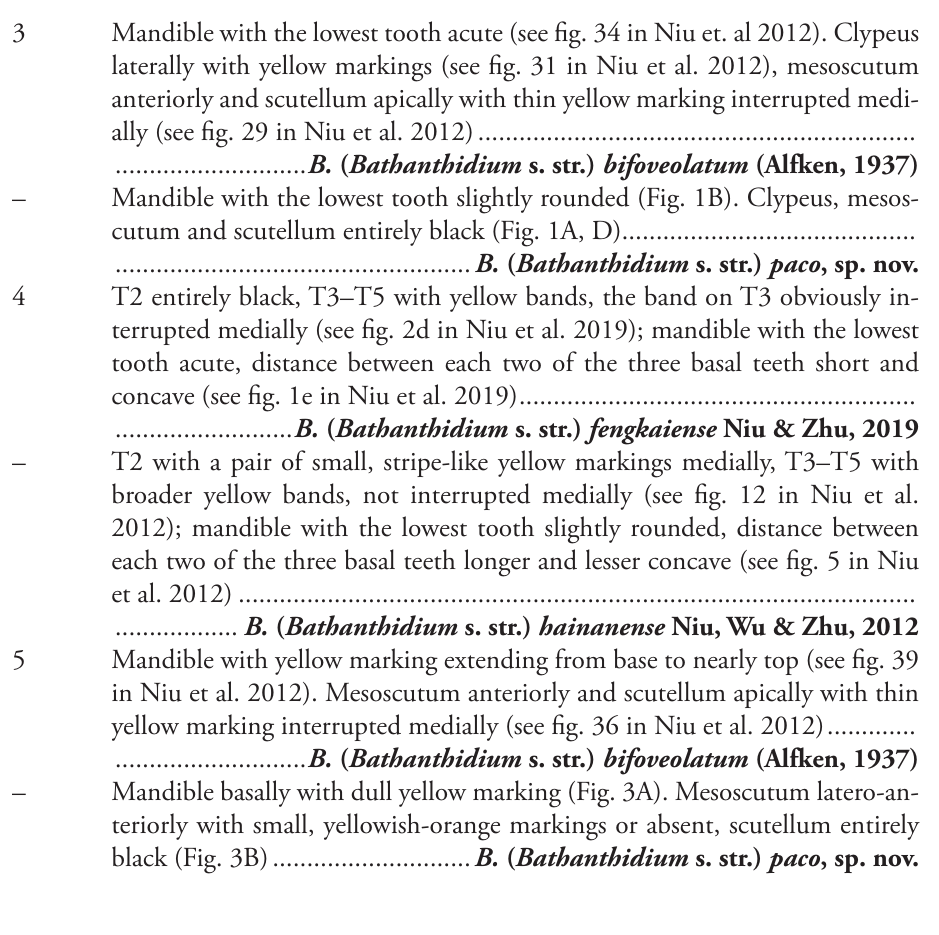
black (Fig. 3B) ............................. B. ( Bathanthidium s. str.) paco , sp.